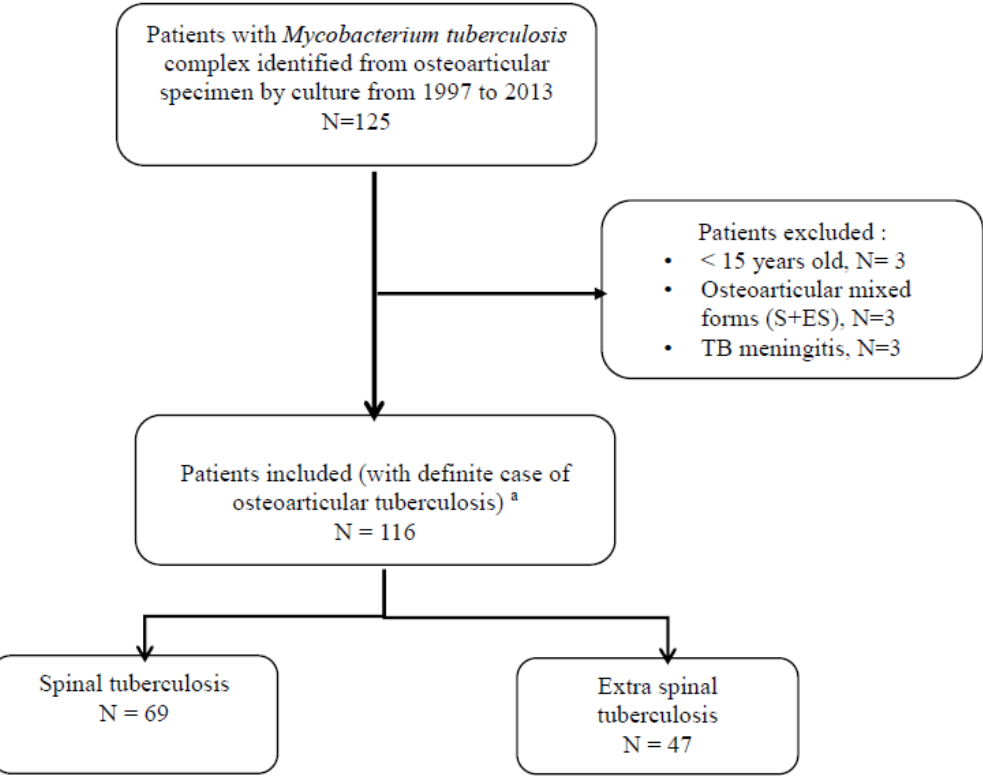
Figure 1. Flowchart for the study. a Definite cases of bone and joint tuberculosis include patients with Mycobacterium tuberculosis complex, identified from a clinical specimen.